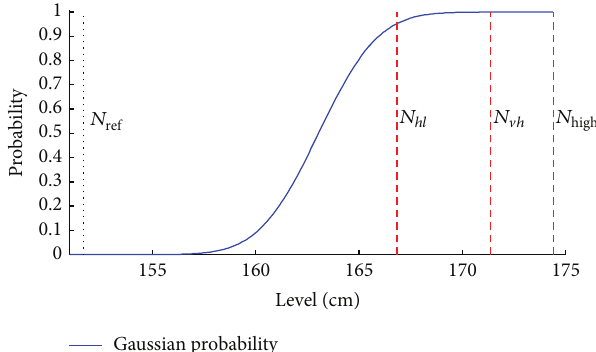
Figure 9: Probability function 𝑝(𝑡) for the definition of risk.